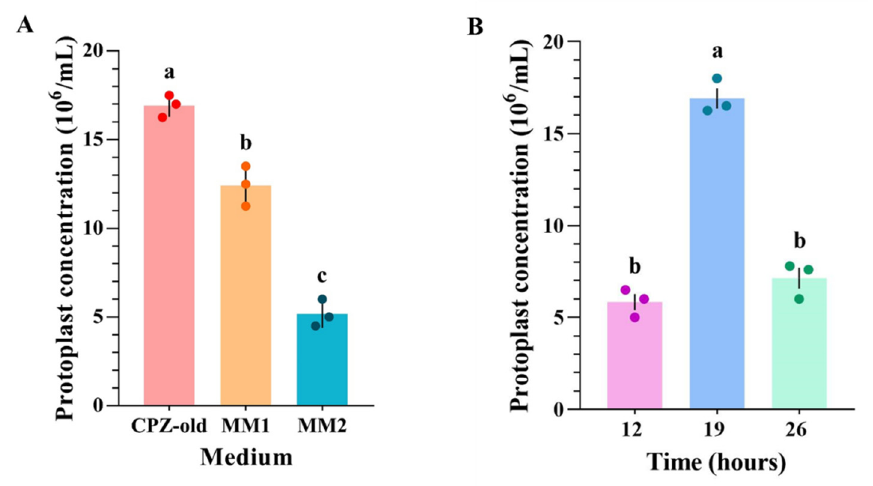
Figure 4. Optimization of protoplast production for PMT of A. niger O1. ( A ) Column diagram of the numbers of protoplast production from A. niger O1 in different media (CPZ-old, MM1, and MM2). ( B ) Protoplast production from A. niger O1 with different culture times (12, 19, and 26 h) in CPZ-old medium. Data represent the mean ± SD. Means with different lowercase letters (a–c) in each graph differed significantly (Tukey’s HSD, p < 0.05). Error bars: SD of the mean from three repeated assays. Table 2. Effect of different enzymatic combinations on the release of A. niger O1 protoplasts. Lysing Ernzymes fom T.